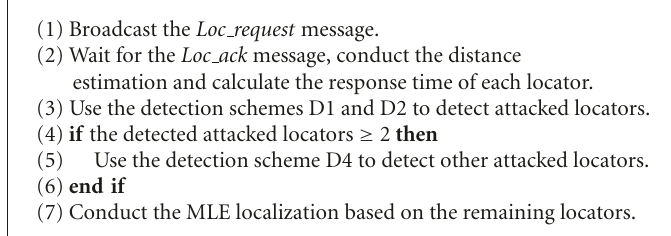
Algorithm 1: Basic TSCD secure localization